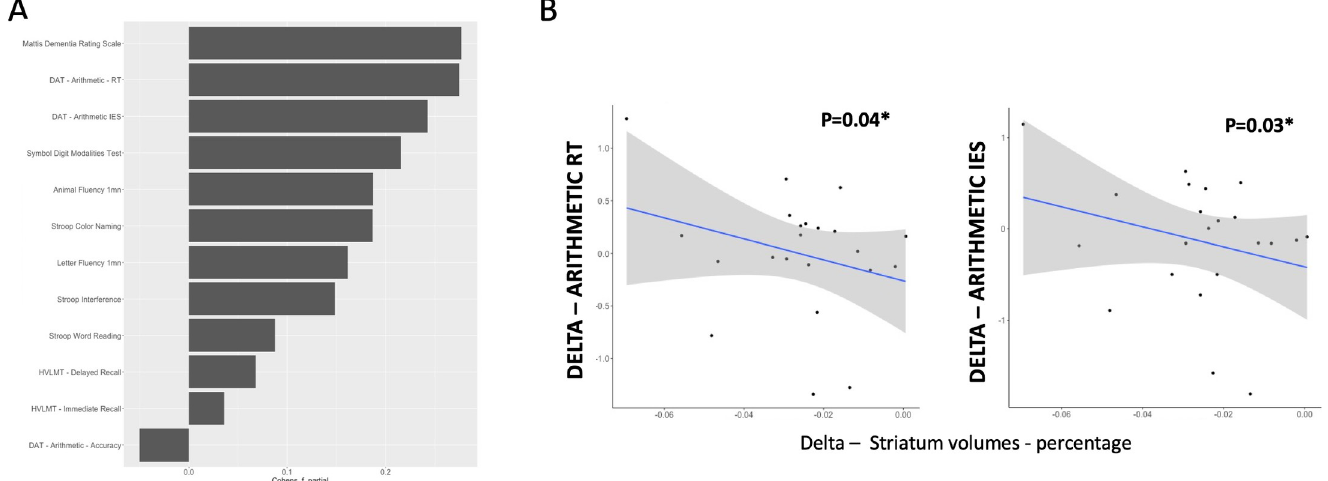
Fig 3. Longitudinal results. A–Longitudinal Cohen’s f effect sizes for each cognitive test between month 1 and month 12 evaluations. B–Association between striatal change and response time and IES changes between Month 1 and Month 12 in HD patients. IES Inverse Efficiency Score, HVLT Hopkins Verbal Memory Test, DAT Digitalized Arithmetic Test, RT Response Time, IES Inverse Efficiency